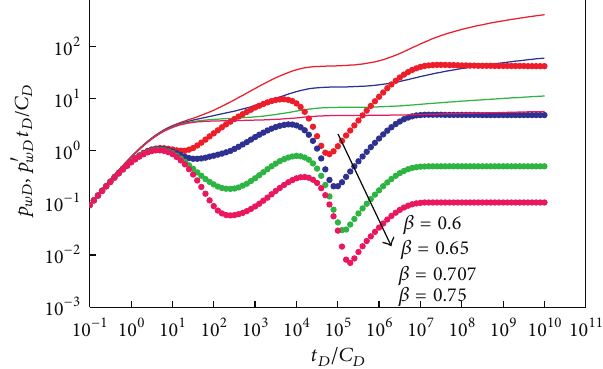
Figure 8: Effect of diameter ratio ( 𝛽 ) on type curves ( 𝛼 = 1 , 𝜃 = 1 , 𝑁 = 4 , 𝑀 = 10 , 𝑙 = 10 m, 𝑑 = 0.05 m, 𝐷 = 1.5 , 𝑇 = 4 , 0.1 m, 𝑆 = −1 , 𝐶 0 0 𝑓 𝑚 = 0.0001 , ℎ = 10 m, 𝐶 = 2.2×10 −5 MPa −1 , = 1 × 10 −4 MPa −1 𝐶 𝐷𝑒 𝑚𝑡 𝑓𝑡